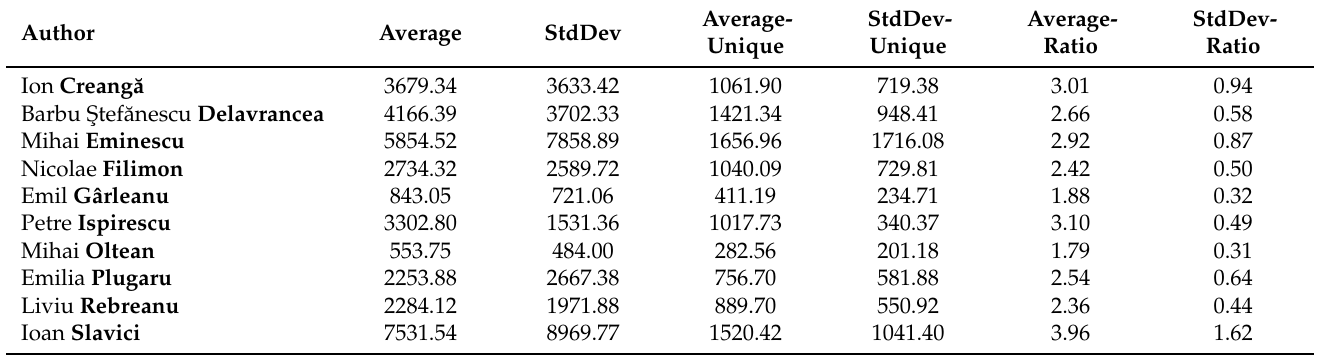
Table 3. Diversity of the considered dataset in terms of the length of the texts (i.e., number of words).